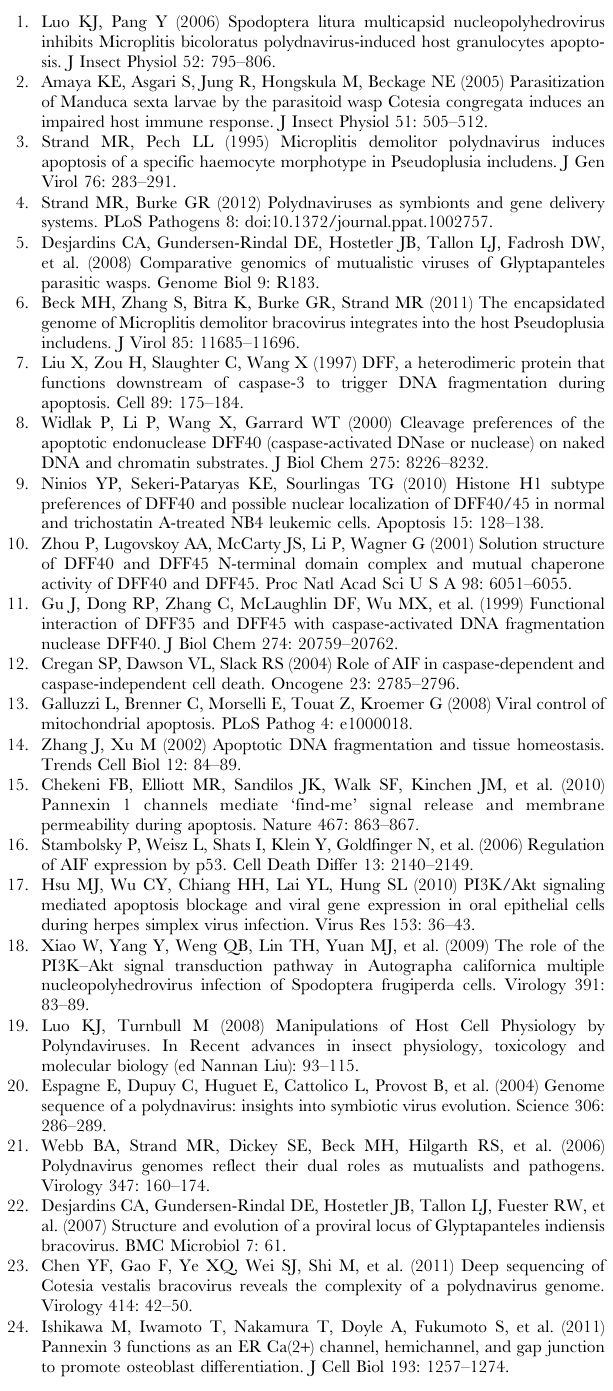
Table S3 EST cluster contigs. Table S4 Primers of completed ORF and short qRT-